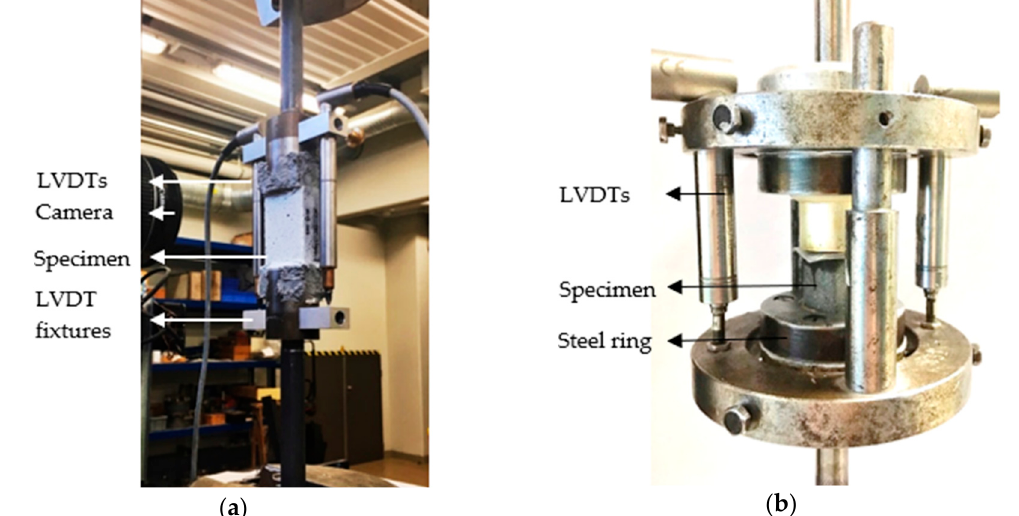
Figure 5. Test setups for: ( a ) quasi-static tension tests and ( b ) quasi-static single-yarn pullout tests.